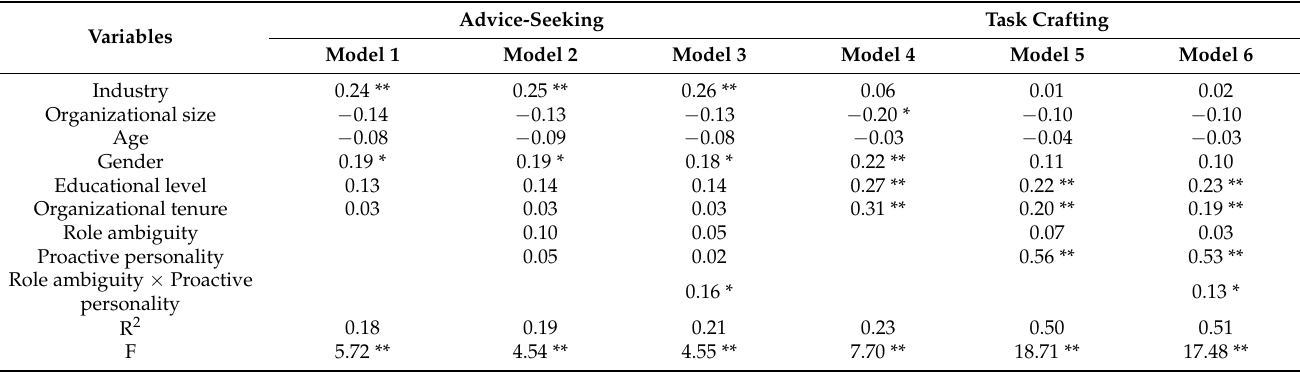
Table 2. Regression results on advice-seeking and task